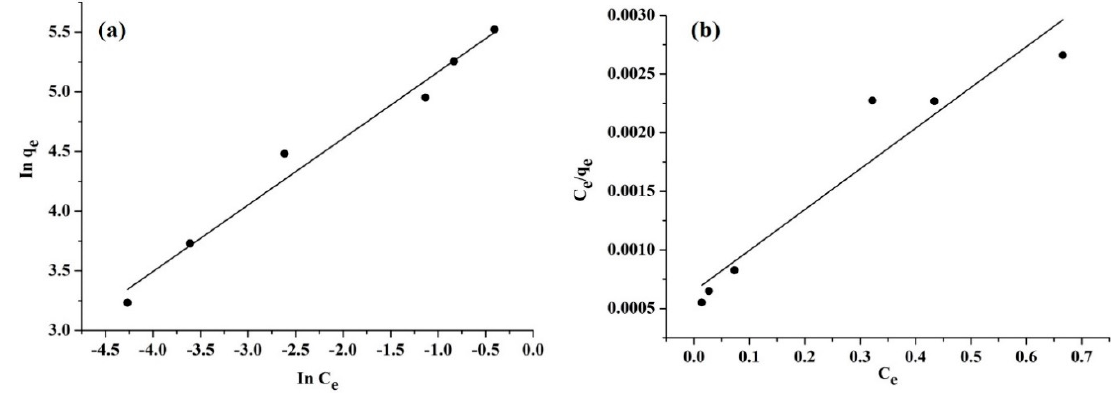
Figure 11. Plots of isotherm models ( a ) Freundlich and ( b ) Langmuir. Table 7. Comparison between the maximum adsorption capacity of hybrid CNTs with other absorbents.